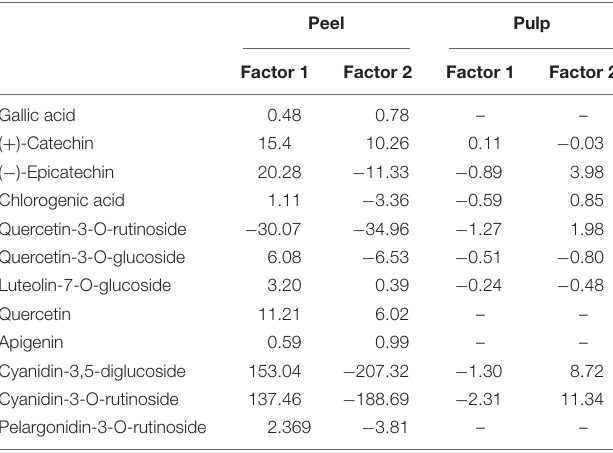
TABLE 4 | Loadings of phenolic compounds in the partial least squares discriminant analysis (PLS-DA) factors for both peel and pulp extracts. Peel Pulp Factor 1 Factor 2 Factor 1 Factor